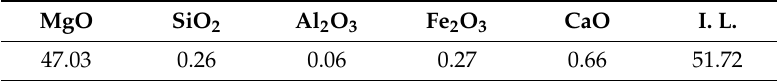
Table 1. Chemical composition of magnesite (wt